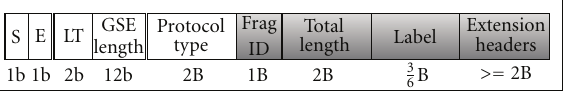
Figure 4: GSE header.